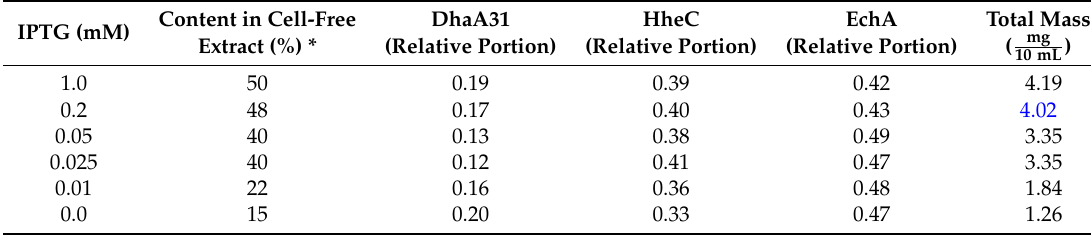
Table A1. Relative fractions of enzymes from Experiment 1.